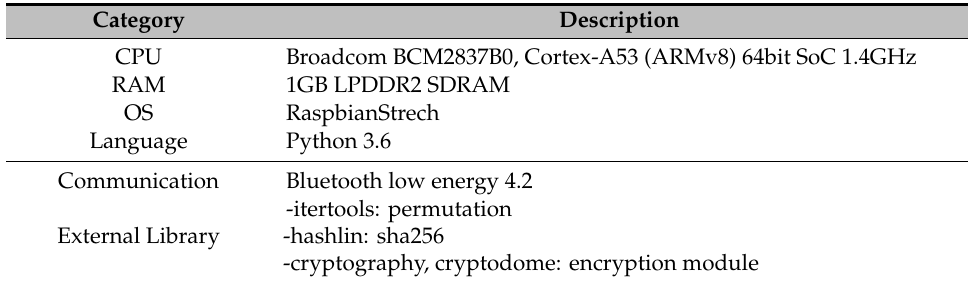
Table 3. System Configuration.